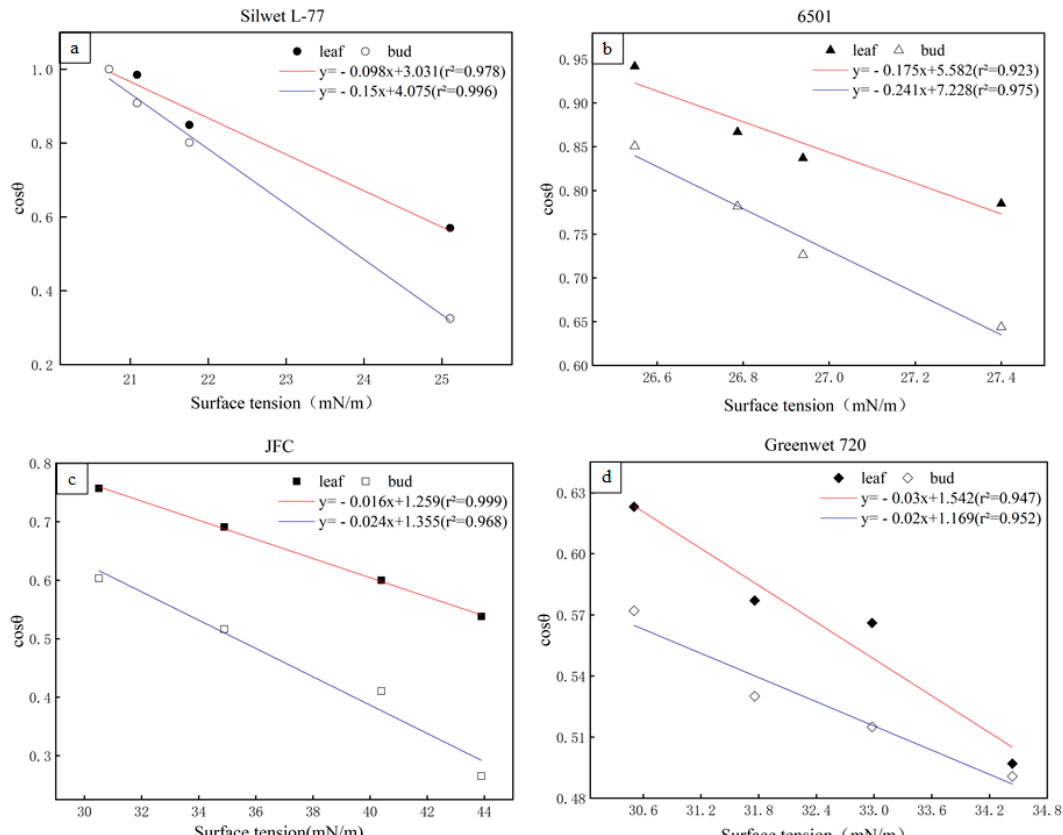
Figure 6. Relationship between cos θ and the surface tension of liquid. Each point represents the corresponding value of the four adjuvants at different concentrations. The straight line is the fitted image, and the specific equation is marked in the upper right corner of each figure: ( a ) Silwet L-77; ( b ) 6501; ( c ) JFC; ( d ) Greenwet 720.